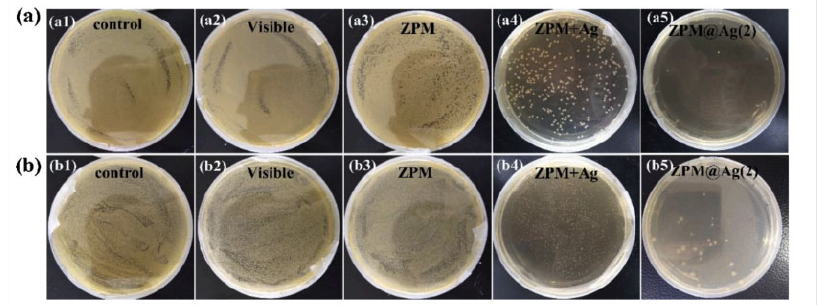
Figure 10. Agar plates showing the antimicrobial effect of Ag-doped ZPM MOFs against ( a ) E. coli and ( b ) S. aureus. Reproduced with permission from [88] .